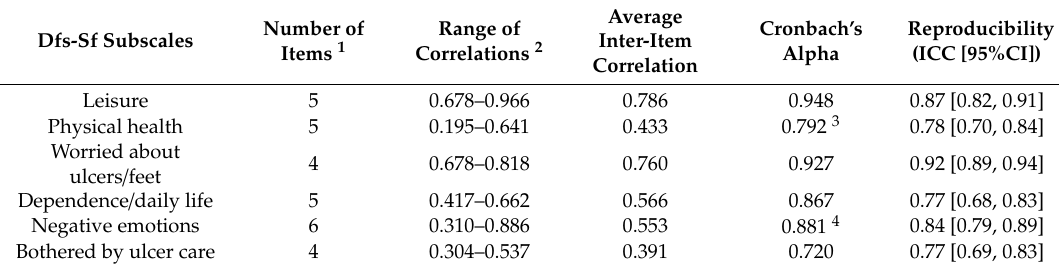
Table 2. Inter-item internal consistency and reproducibility of the Diabetes Foot Ulcer-Short Form (DFS-SF) subscales.